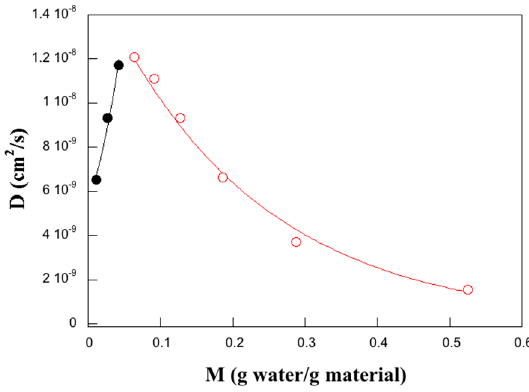
Figure 8. Water diffusivity as a function of water concentration; the black curve corresponds to the best fit using Equation (7) (R = 0.989) and the red curve corresponds to the best fit using Equation (8) (R = 0.997).